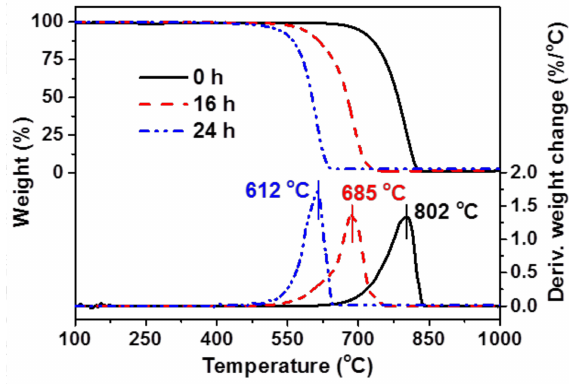
Figure 8. Thermogravimetry analysis (TG/DTG) profiles of pristine GFs, OGFs-16 and